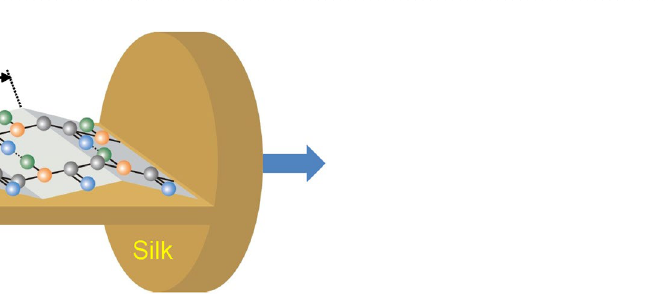
write approach has a strong potential for bio-medical implants, e.g., a plasma laser deposition of crystalline silk 42 and β -sheet formation form amorphous fibroin under 266 nm laser irradiation 43 have been demonstrated. By applying stretching to films of pure sericin, which is amorphous in silk fiber cladding, a molecular orientation can be imprinted 44 . Cast-drying of volumetric silk workpieces for a mechanical post-processing in orthopedic